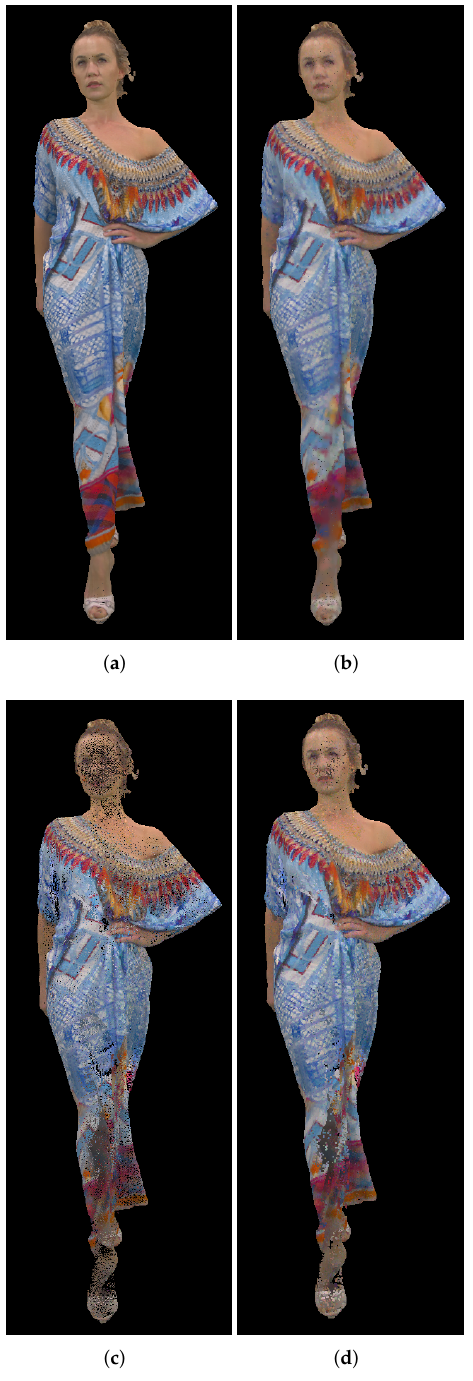
Figure 12. Point clouds to panorama, using Miller projection and 9-bit range depth: ( a ) Original point cloud “longdress_vox10_1060.ply” (799,765 points; point size 1 in MeshLab); ( b ) Decompressed point cloud after Poisson reconstruction (1,161,124 points; point size 1 in MeshLab); ( c ) Decompressed point cloud before Poisson reconstruction (430,793 points; point size 1 in MeshLab); ( d ) Decompressed point cloud before Poisson reconstruction (430,793 points; point size 2 in